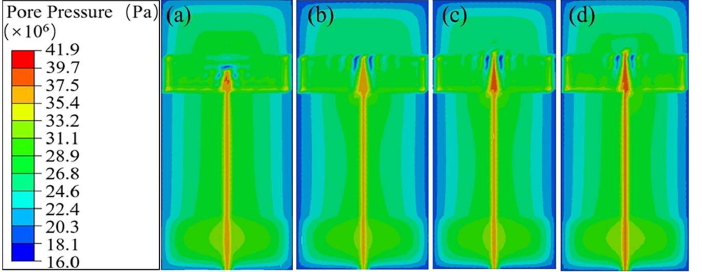
Figure 11. Pore pressure distribution cloud after fracturing under different Young’s modulus conditions: ( a ) 28 GPa, ( b ) 32 GPa, ( c ) 34 GPa, ( d ) 36 GPa.